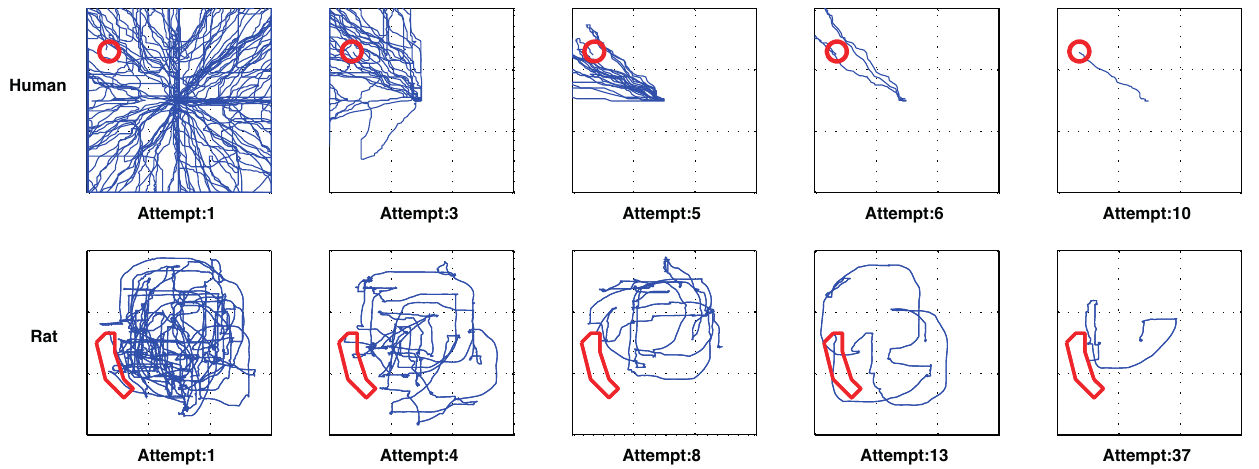
Figure 3. Movement traces (blue) for a spatial target (outlined in red) for typical (a) human and (b) rat participants.